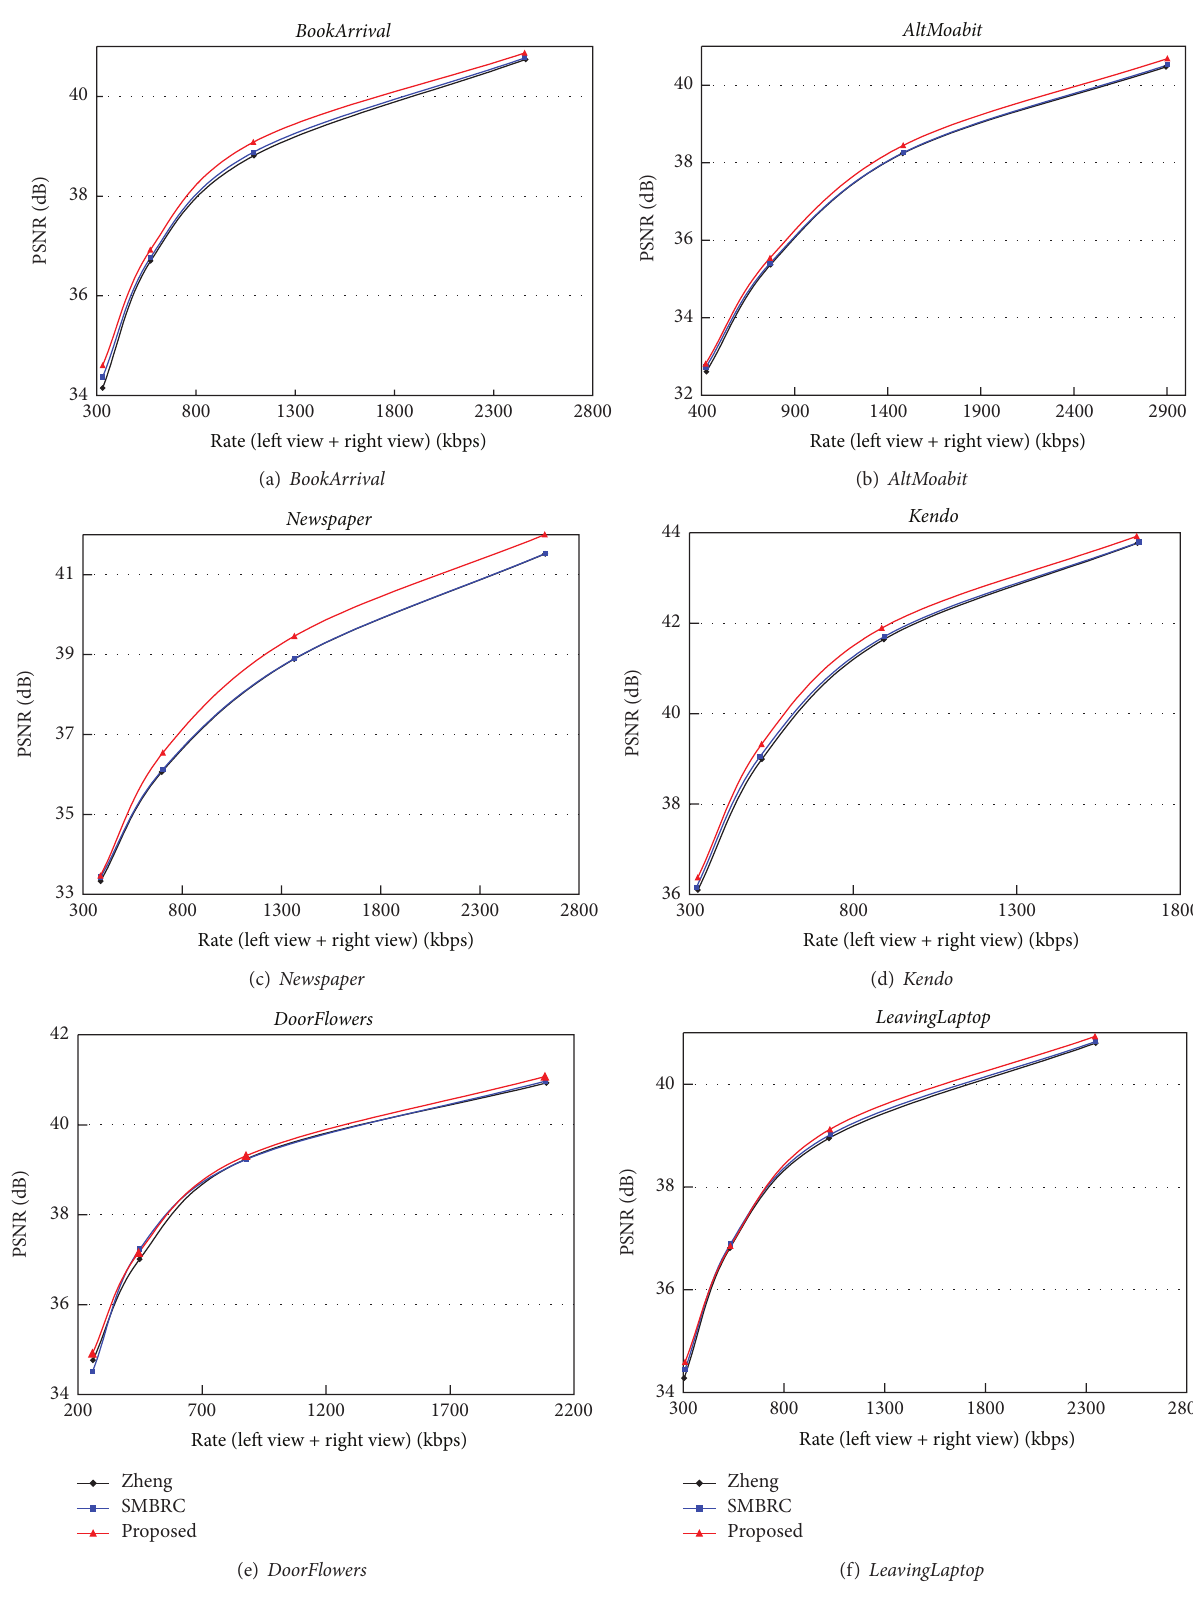
Figure 5: The R-D performance comparisons of three